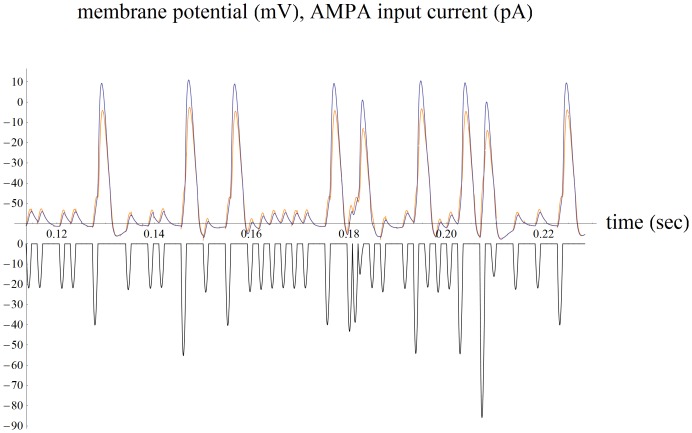
For comparison a spike train is shown from a biophysically-based 10 compartment model of the ANF dendritc spike generator.The simplified 3d SNIC model is a reduction of this more detailed model in which AMPA current is input into compartment 1, leak conductances are equally distributed throughout the 10 compartments, and the spike machine (sodium and delayed rectifier conductances) placed into compartment 10. The characteristic frequency of the noisy AMPA current pulses is 440 Hz (black). Fast negative feedback from low threshold voltage-gated potassium conductance spread throughout the 10 compartments extends the generator’s dynamic range to about 38 dB. The sample spike train is driven by an average of 1 vesicle released by the IHC per sound wave cycle and includes vesicle release noise, with some of the vesicles released by the simulated IHC having an incorrect phase. 1 mV of Gaussian voltage noise is included. For low noise the action potentials phase lock to the AMPA current pulses. By comparing the attenuation of the back propagating action potentials in compartment 1 (orange) to the generator’s action potentials in compartment 10 (blue) the model dendrite can be seen to have an electrical length of about 0.22 space constant for small input current. The dendrite “lengthens” to 0.26 space constant for large input by turning on more low threshold potassium conductance which increases its attenuation (a static potential is e-fold damped in 1 space constant). The epsps from compartment 1 (orange) are similarly attenuated after arriving at the generator compartment (blue).